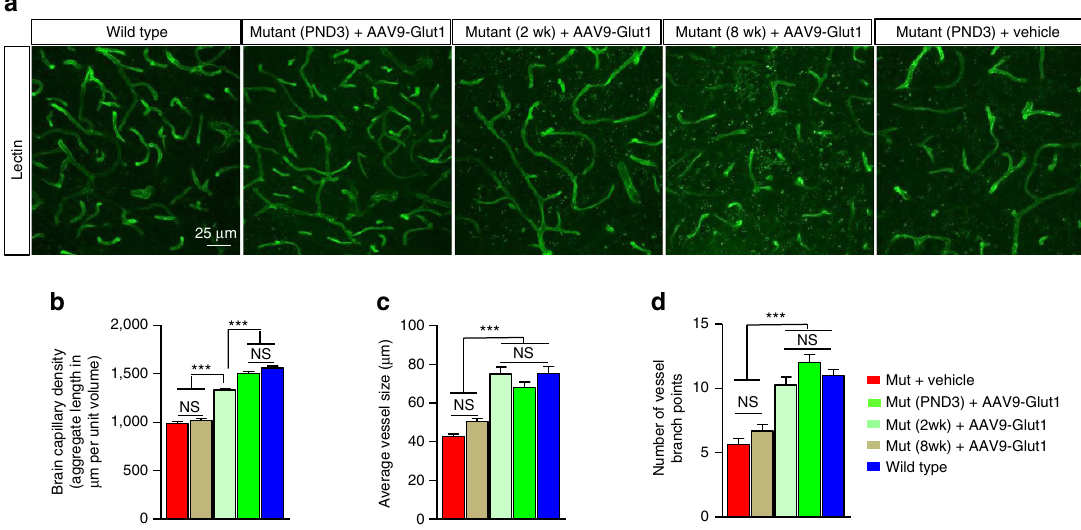
Figure 7 | Brain capillary network restored following early but not late repletion of the Glut1 protein. ( a ) Representative immuno-histochemical photomicrographs of the thalamic microvasculature in relevant controls and mutants treated with AAV9-Glut1 at various stages of the disease. Note persistent fragmentation and reduced complexity of the capillary network in vehicle-treated mutants and mutants treated at 8 weeks of age, an intermediate capillary density in cohorts treated at 2 weeks of age and a relatively normal microvasculature in mice administered virus at PND3. Quantitative estimation of ( b ) aggregate cerebral capillary length, ( c ) mean vessel length and ( d ) number of branches per capillary in the different cohorts of mice. ***, P o 0.001, one-way ANOVA, n Z 9 regions from N Z 3 mice in each cohort